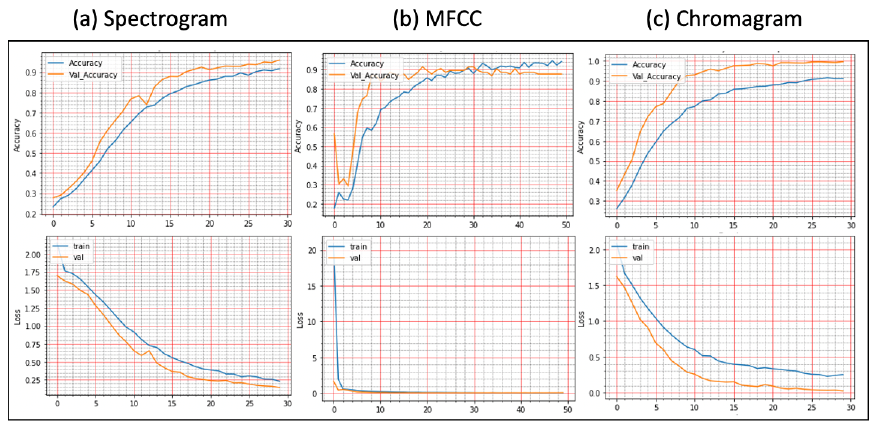
Figure 9. Heart Condition Classification (Accuracy vs. Loss): The Fusion Network Model (FDC-FS) was Evaluated with Three Features: ( a ) Spectrogram, ( b ) MFCC, ( c )